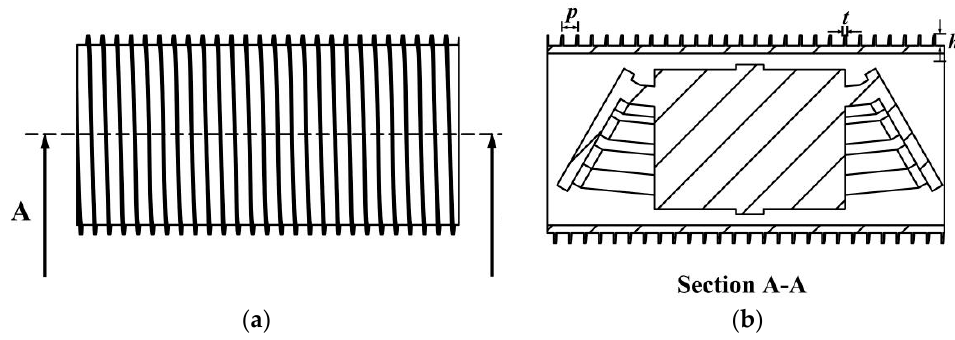
Figure 2. Geometric details and schematic diagram from ( a ) front view; ( b ) sectional view.